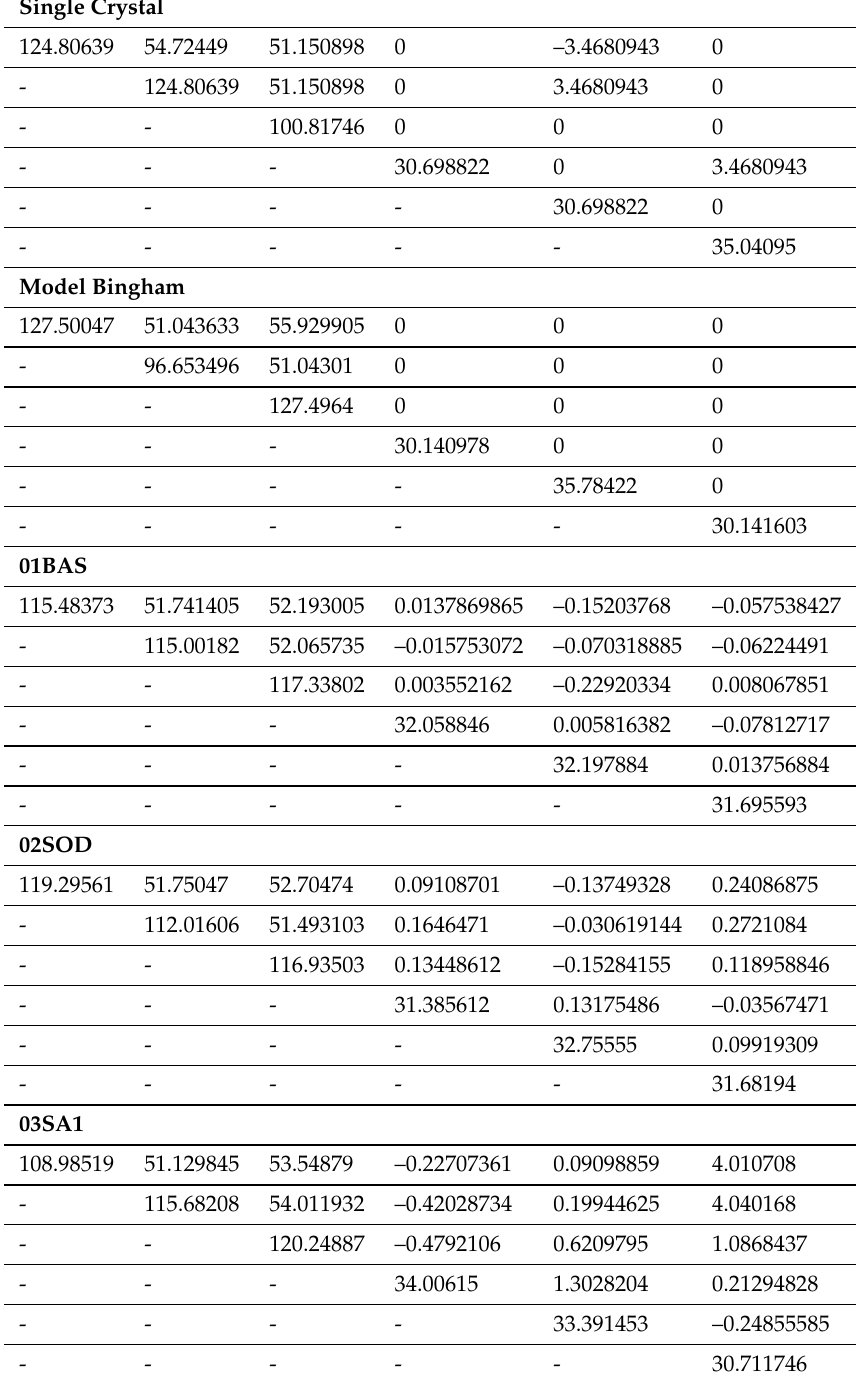
Table 4. Homogenized elastic tensors for the studied samples—[GPa]—density = 2.712 g/cm 3 . Single